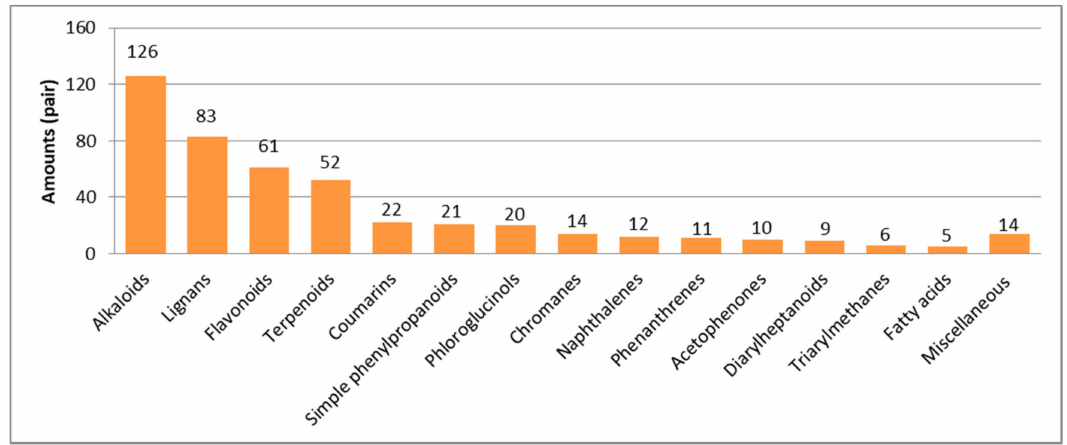
Figure 37. Statistics of different types of enantiomeric pairs from